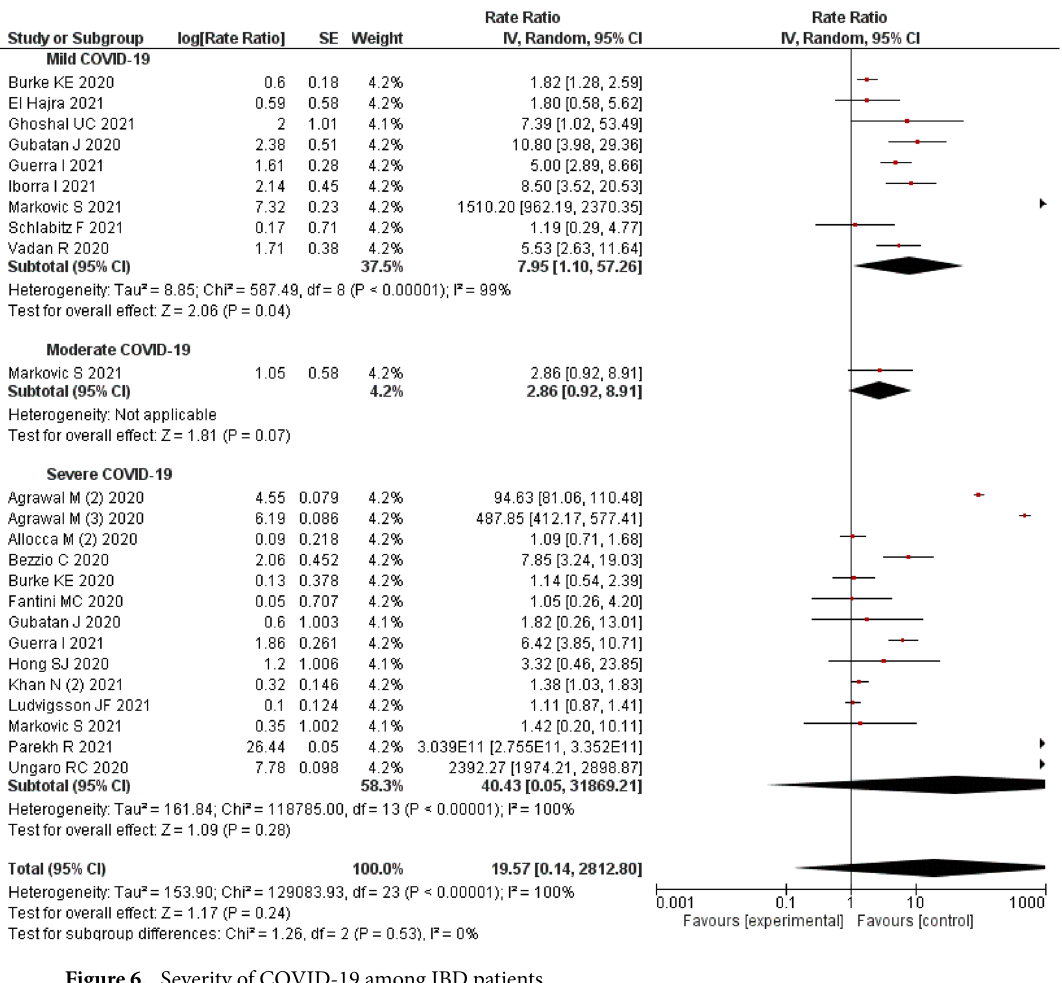
Figure 6. Severity of COVID-19 among IBD